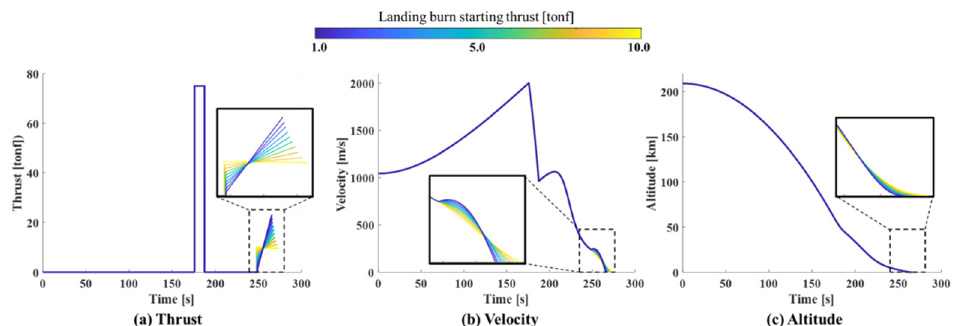
Figure 17. Trajectory data with different landing-burn starting thrust values (altitude of entry-burn start: 60 km). ( a ) Thrust; ( b ) Velocity; ( c ) Altitude.